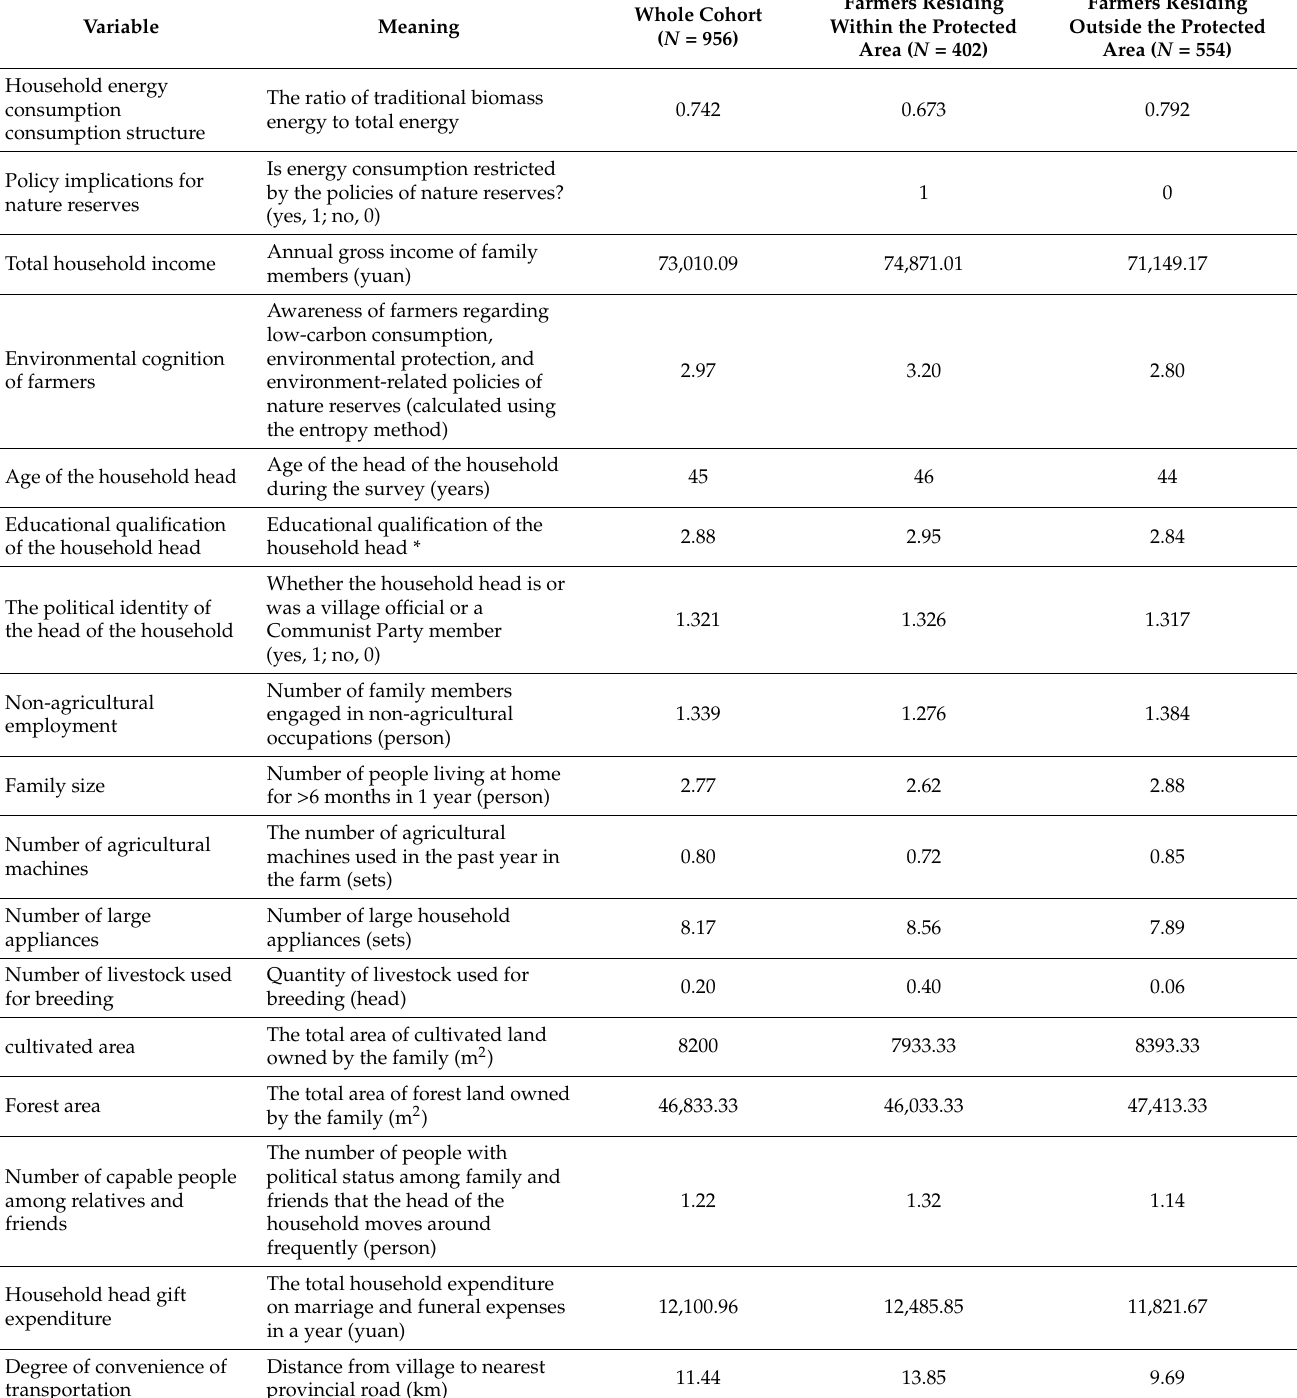
Table 3. The definitions of the variables and the descriptive statistics